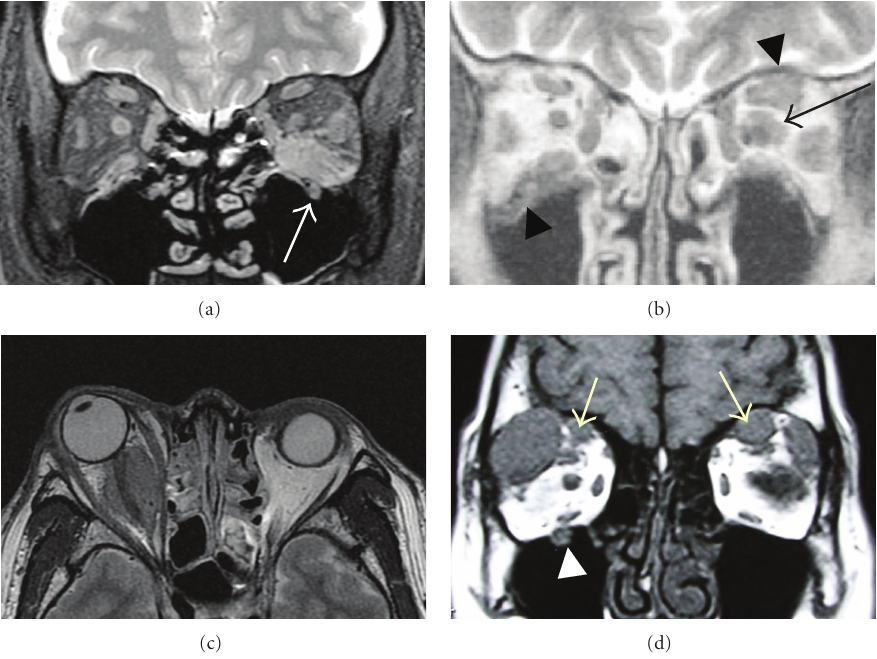
Figure 3: Representative cases with IgG4-related orbital inflammatory lesions other than lacrimal glands. (a) Enlargements in the left inferior rectus muscle and infraorbital nerve (arrow) in a 65-year-old man with a serum IgG4 of 404 mg/dL (case number 7 in Table 1). (b) Swelling of the left superior and lateral rectus muscles, a mass lesion around the left optic disc (arrow), and enlargements of the left supraorbital nerve and the right infraorbital nerve (arrow heads) were seen in a 60-year-old man with a serum IgG4 of 463mg/dL (case number 8). (c) Mass lesion around the right optic disc was observed in a 44-year-old man with a serum IgG4 of 599 mg/dL (case number 11). (d) Bilateral supraorbital nerve enlargements (arrows) and right infraorbital nerve enlargement were observed in a 47-year-old woman with a serum IgG4 of 1000 mg/dL (case number 16). Magnetic resonance images are T1-weighted in (b) and (d) and T2-weighted in (a) and (c).